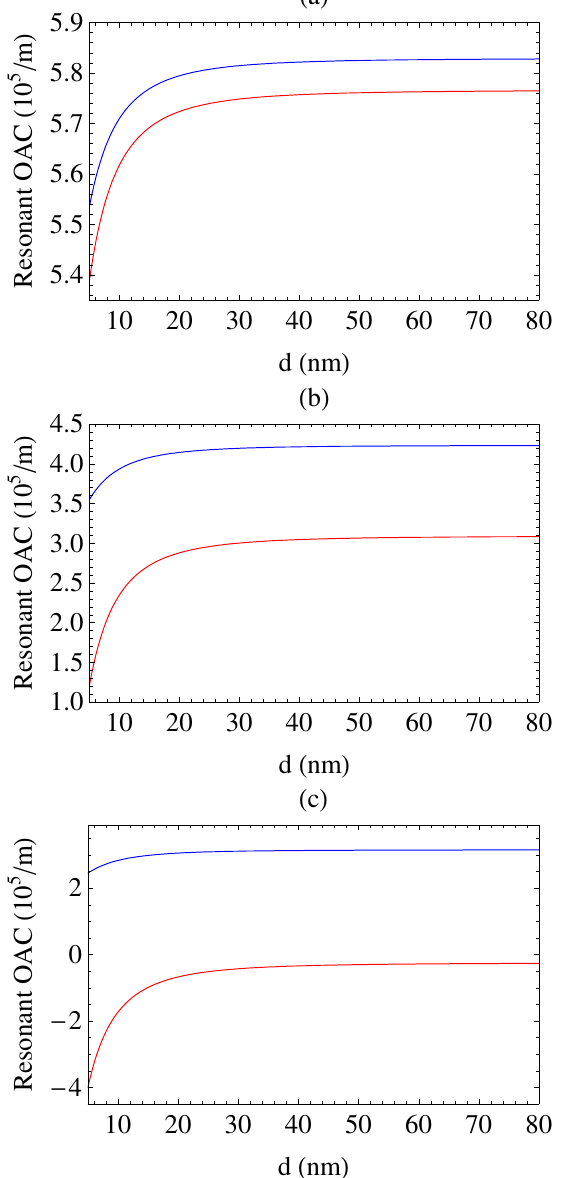
Figure 7. (Color online) The same as in Figure 5 but for the electric field polarized along the x